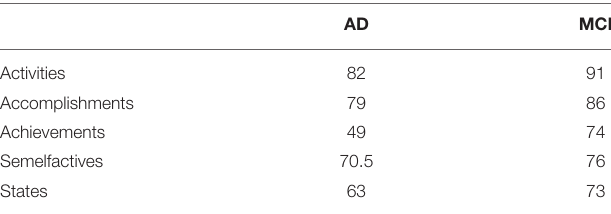
TABLE 6 | Percentages of correct responses by group and lexical aspect in the naming task.